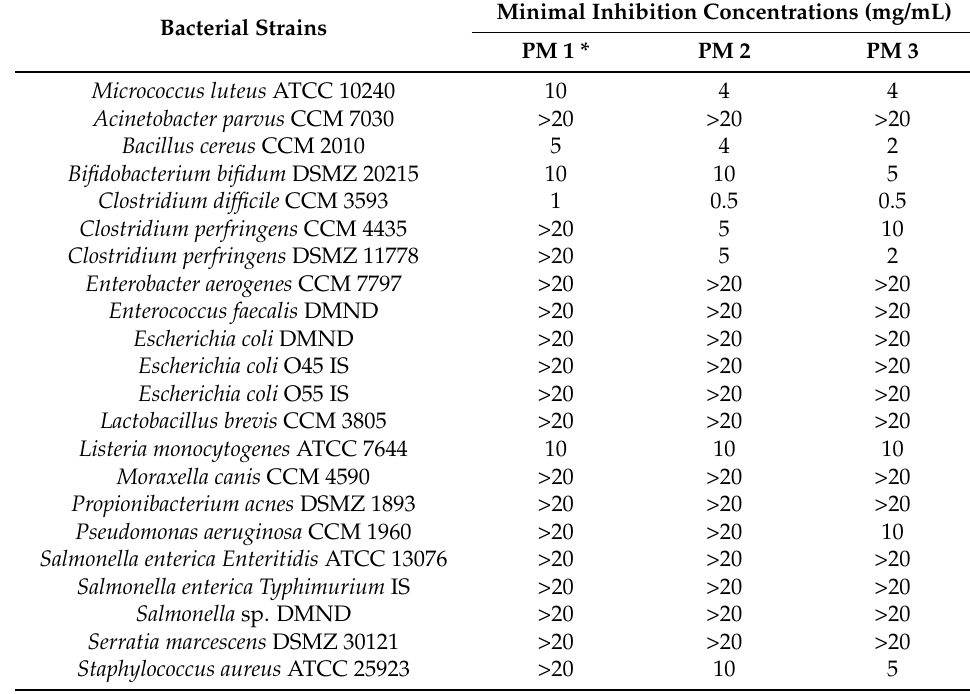
Table 2. Antimicrobial activities of P. magnifica